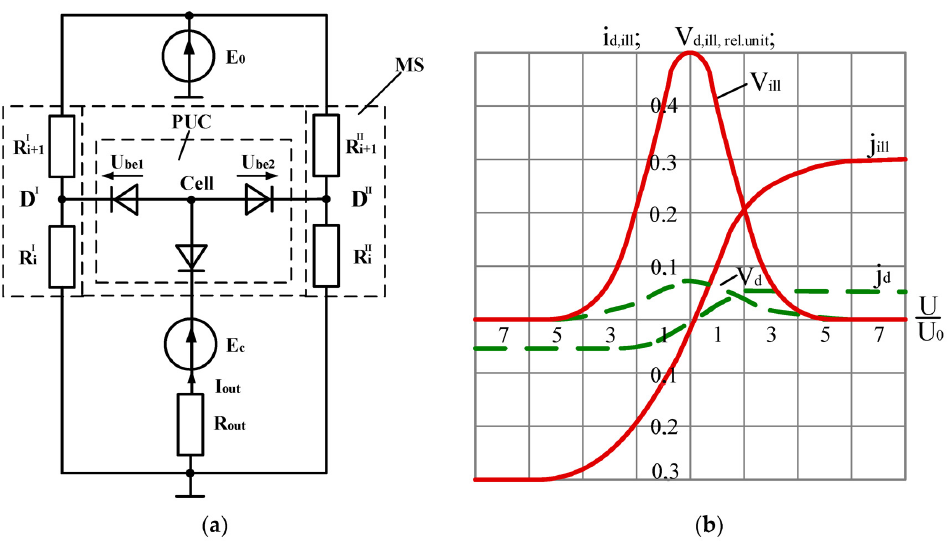
Figure 6. Equivalent scheme of the multiscan photodiode unit cell in scanistor enabling: ( a ) full scheme; ( b ) volt-ampere characteristics and video signal (in darkness—dashed line; at illumination—solid line).